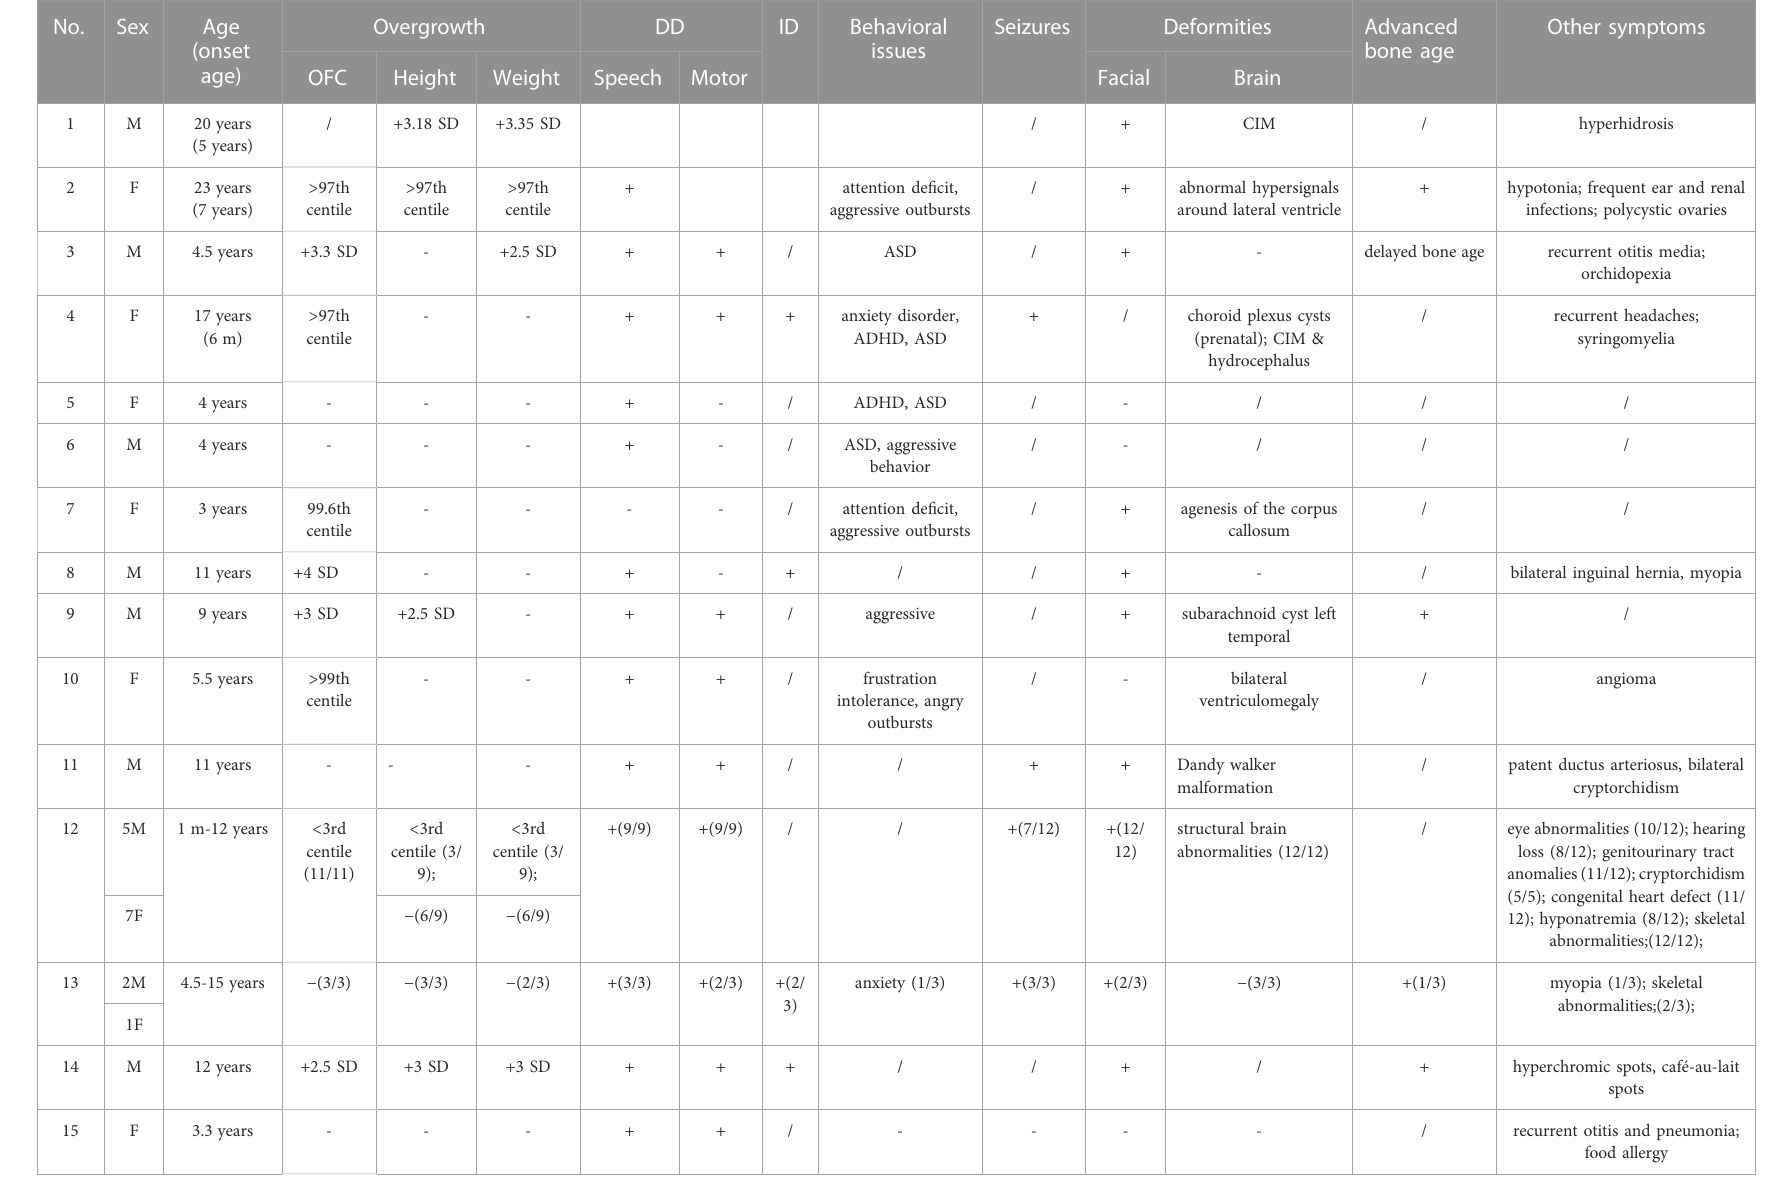
TABLE 2 Summary of clinical symptoms in patients with SETD2 gene mutation.